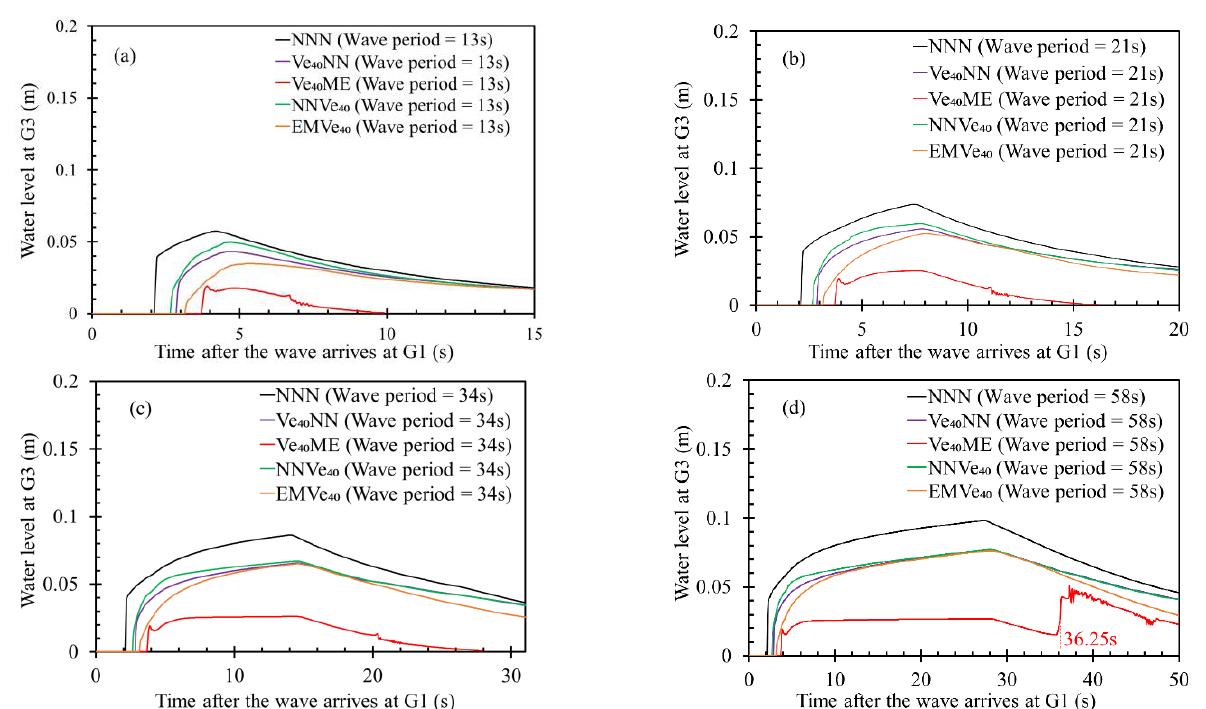
40 ME. The maximum water level increases with the increase in tsunami pe-